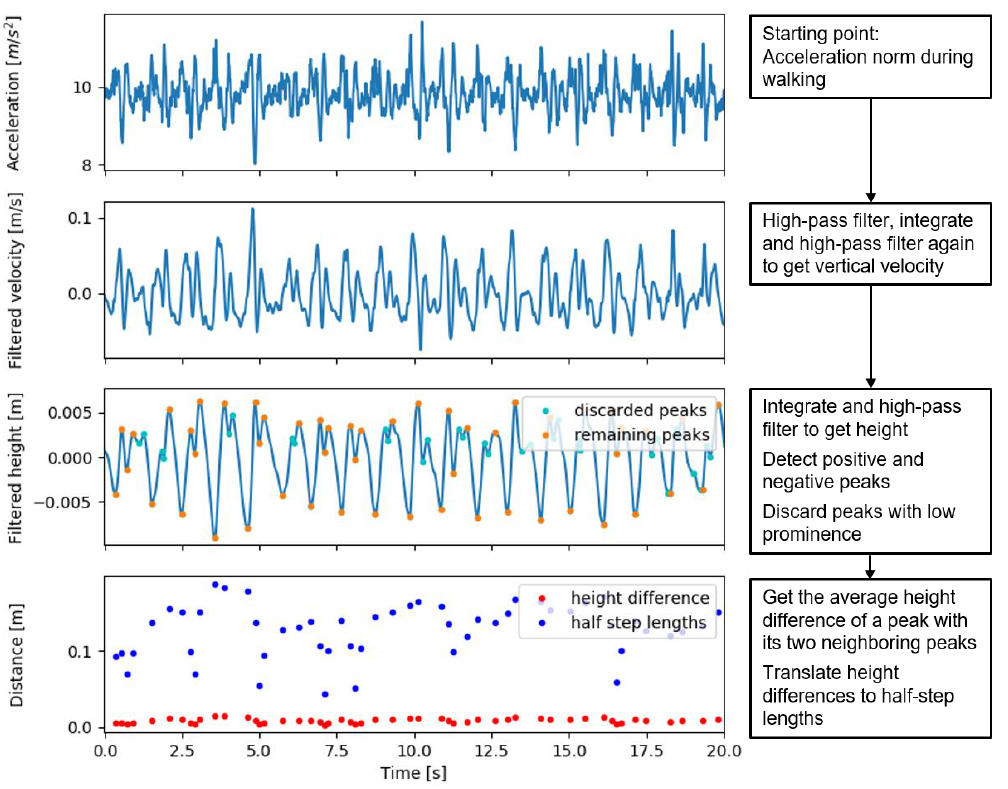
Figure 3. Acceleration, velocity, and height signals with detected peaks in the different steps of the updated inverted pendulum walking speed estimation algorithm.